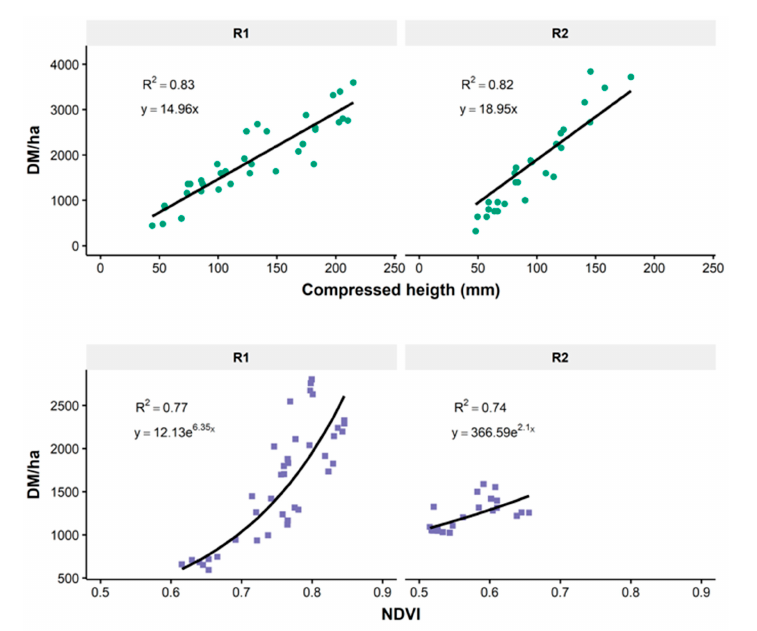
Figure 3. Calibration equations of compressed height into pasture biomass (kg DM/ha) for the electronic rising plate meter ( ● , — ) and normalized difference vegetation index (NDVI) into pasture biomass for Planet satellite ( ■ ; — ) and Sentinel satellite ( ▲ ; — ), for regrowth periods 1 and 2 (R1 and R2, respectively).